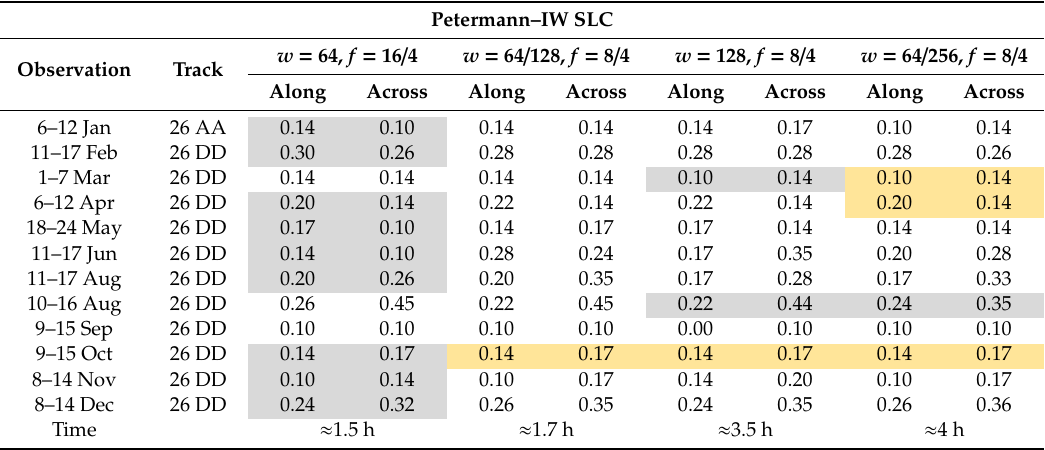
Table 3. PG, IW SLC product class experiments, RMSE (expressed in m / day) with respect to available literature data measured along selected along flow and across flow transects.